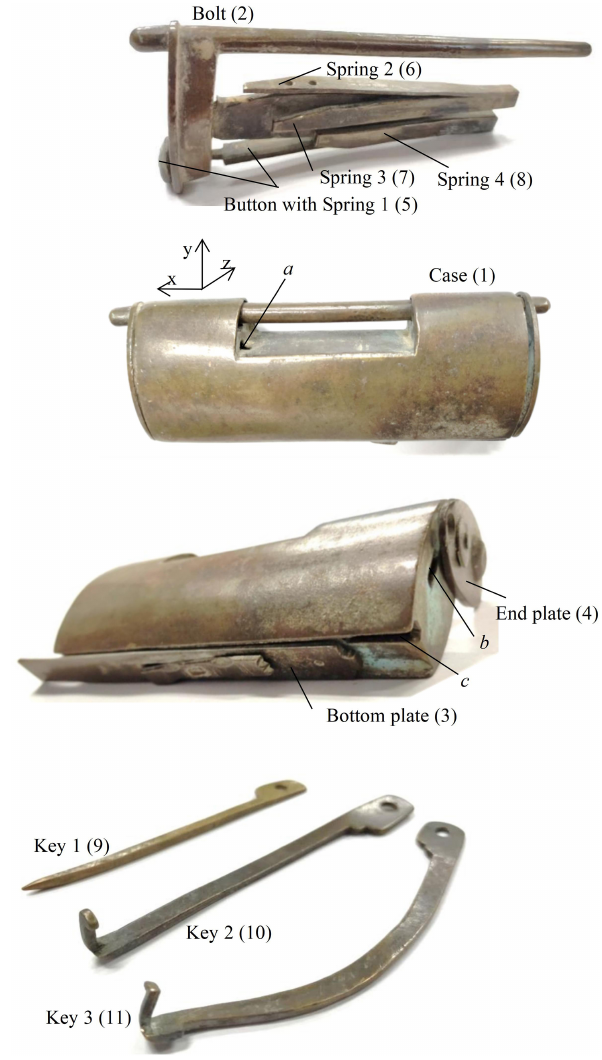
Figure 4. Padlock with pushing button (Ancient Chinese Machin- ery Cultural Foundation